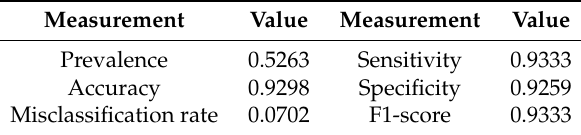
Table 1. Results for Semantic frontier classification.